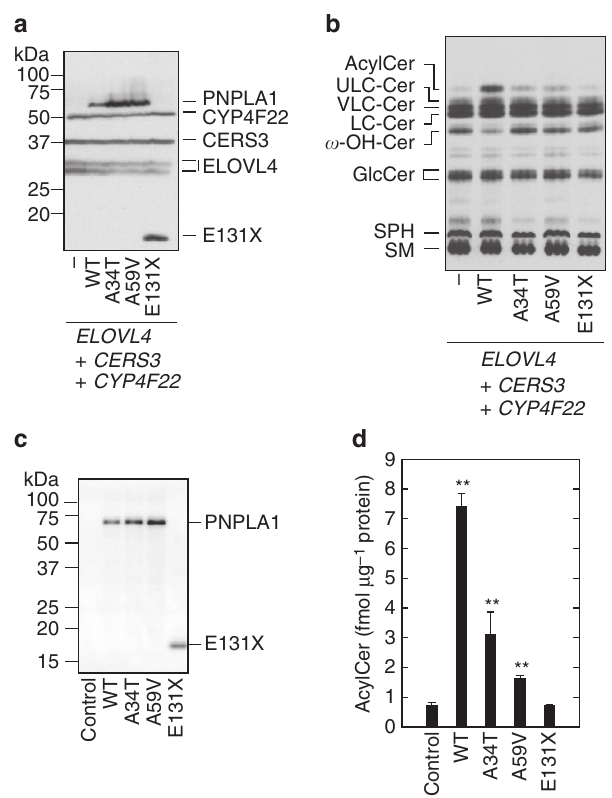
Figure 6 | PNPLA1 activity is impaired in ichthyosis-causative mutants. ( a , b ) HEK 293Tcells were transfected with the plasmids encoding 3xFLAG- ELOVL4 , 3xFLAG-CERS3 , 3xFLAG-CYP4F22 and 3xFLAG-PNPLA1 (wild type (WT) or mutant) as indicated. ( a ) Total cell lysates were separated by SDS- PAGE and subjected to immunoblotting with anti-FLAG antibody. ( b ) Cells were labelled with [ 3 H]sphingosine in the presence of 25 m M linoleic acid for 6h at 37 (cid:2) C. Lipids were extracted, separated by normal-phase TLC and detected by autoradiography. AcylCer, acylceramide; Cer, ceramide; GlcCer, glucosylceramide; SM, sphingomyelin; SPH, sphingosine; o -OH-Cer, ULC o -hydroxyceramide. Three independent experiments gave similar results, and a representative result is shown. ( c , d ) Genes on control plasmid (pEU-E01-T1R1) or plasmid encoding wild type (WT; pEU-E01-3xFLAG- PNPLA1) or mutant PNPLA1 (for A34T, pEU-E01-3xFLAG-PNPLA1(A34T); for A59V, pEU-E01-3xFLAG-PNPLA1(A59V); or for E131X, pEU-E01- 3xFLAG-PNPLA1(E131X)) were transcribed in vitro using SP6 RNA polymerase. The resulting mRNAs were then incubated with wheat germ lysates and phosphatidylcholine-based liposomes containing TG and C30:0 o -hydroxyceramide. ( c ) Proteins associated with the resulting proteoliposomes were separated by SDS-PAGE, followed by immunoblotting with anti-FLAG-antibody. ( d ) An in vitro acylceramide synthesis assay was performed by incubating proteoliposomes for 1h at 37 (cid:2) C. Lipids were extracted, and the C30:0 acylceramide EOS was quantified by LC-MS analysis. Values represent the means ± s.d.s of three independent experiments. Statistically significant differences compared to control are indicated (two-tailed Student’s t test; ** P o